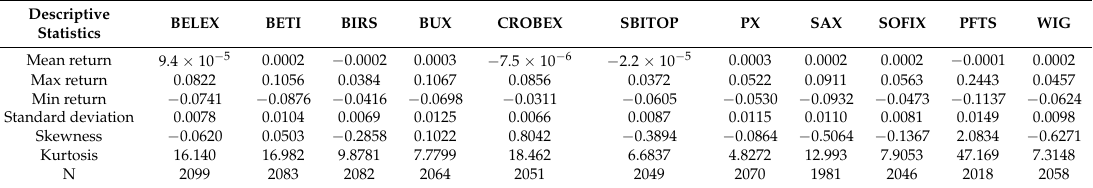
Table 1. Descriptive statistics for return series in the